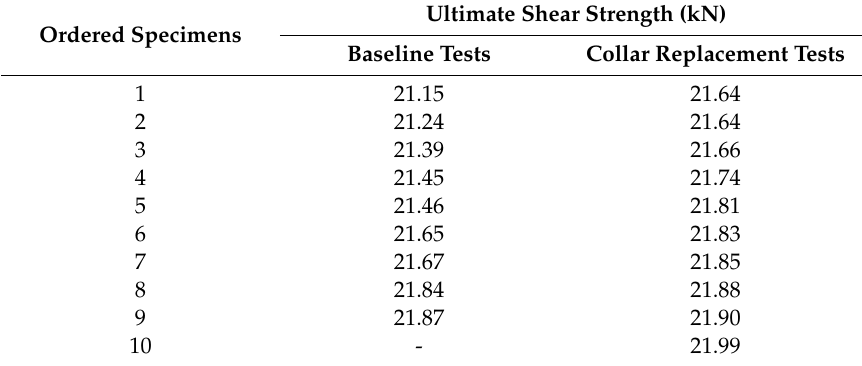
Table A1. Experimental data for static shear strength of fastener pins—Figure 5. Ordered